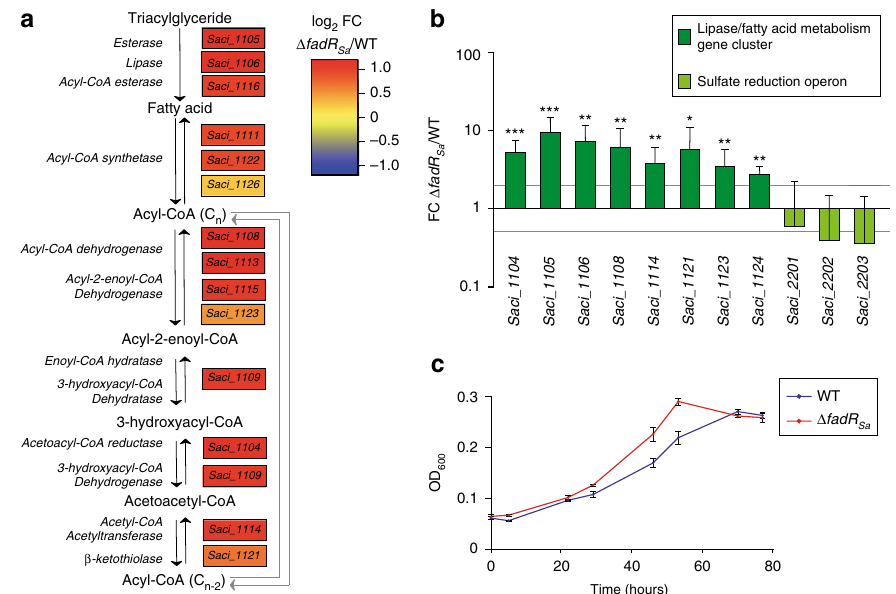
Fig. 6 FadR Sa exerts a repression on the transcription of the catabolic fatty acid metabolism/lipase gene cluster. a Reconstruction of the lipid degradation and fatty acid β -oxidation pathway with indication of the putative functions of genes in the Saci_1103 - Saci_1126 gene cluster predicted to be involved in this metabolic pathway. This is based on genomic annotations. For each of these genes, differential expression in S. acidocaldarius MW001 Δ fadR Sa , as measured by RNA-seq analysis, is shown in a heat map format expressed as the log 2 of the fold change expression in the Δ fadR Sa versus its isogenic wildtype strain. b Relative gene expression as determined by qRT-PCR for a subset of the genes of the Saci_1103 - Saci_1126 gene cluster and for genes belonging to the sulfate reduction operon. Gray lines represent a fold change of 2 and 0.5, respectively. Error bars represent biological variation for triplicates (standard deviations). An asterisk indicates a p -value between 0.05 and 0.01, a double asterisk between 0.01 and 0.001, and a triple asterisk smaller than 0.001, as determined in a statistical t test. c Growth curves of MW001 and MW001 Δ fadR Sa strains in Brock medium containing 2 mM hexanoate as sole carbon source. Values are averages of four biological replicates with error bars representing standard deviations. Doubling times ( T d s) were calculated by modeling the exponential section of the growth curves. Representative curves are shown for multiple independently performed